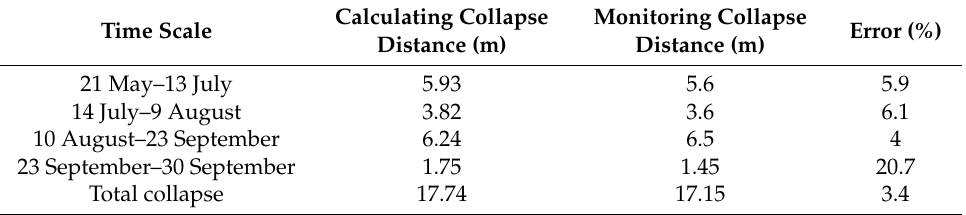
Table 9. Numerical results, field measurements and errors for surveying Section 5 of Figure 1. Time Scale